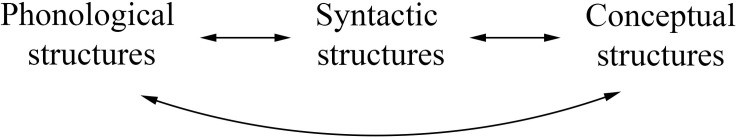
The parallel architecture.